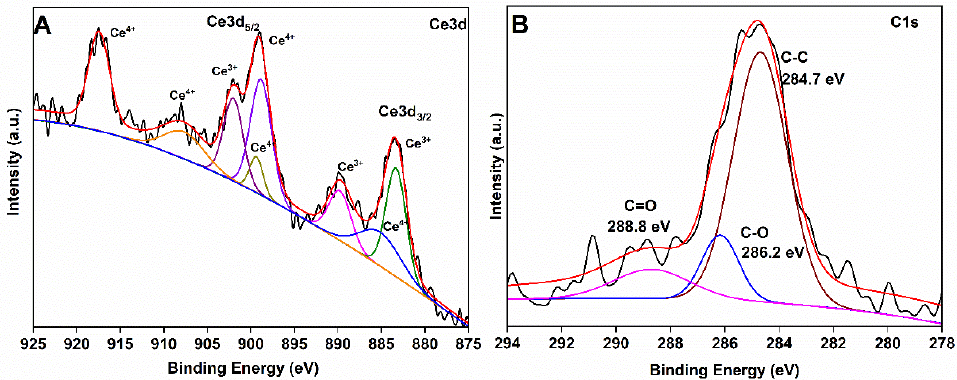
Figure 4. High-resolution XPS spectra of; ( A ) Ce3d and ( B ) C1s in CeO 2 @GO composite. Figure 5. represents the FTIR spectra of the CeO 2 @GO-CTA MMMs. The characteris-